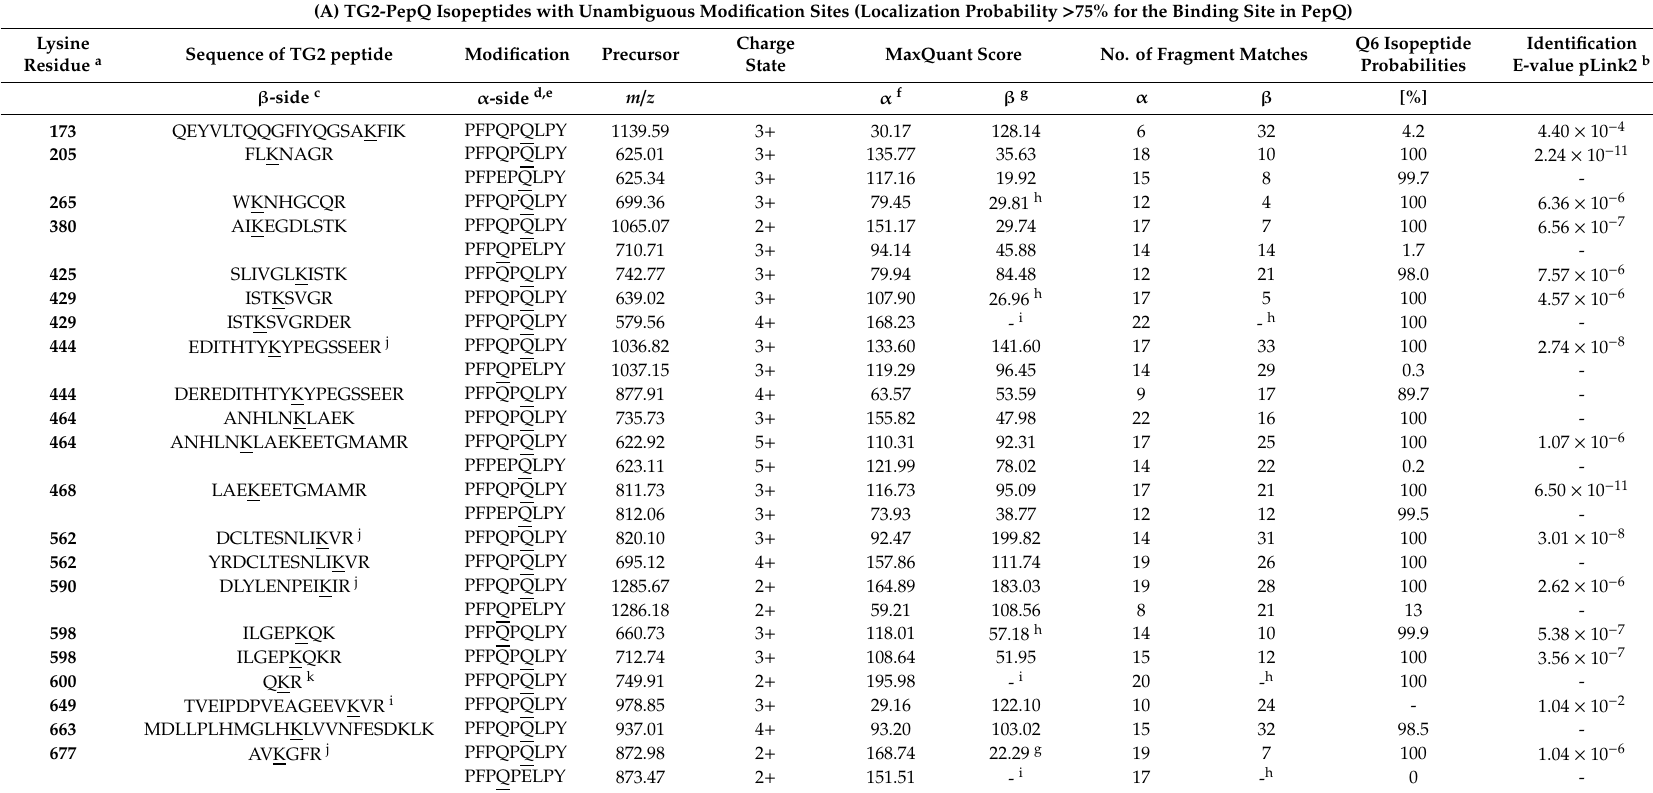
Table 1. Lysine residues of TG2 involved in the formation of 34 di ff erent isopeptides with the model peptide PepQ (PFPQ 4 PQ 6 LPY). (A) TG2-PepQ Isopeptides with Unambiguous Modification Sites (Localization Probability > 75% for the Binding Site in